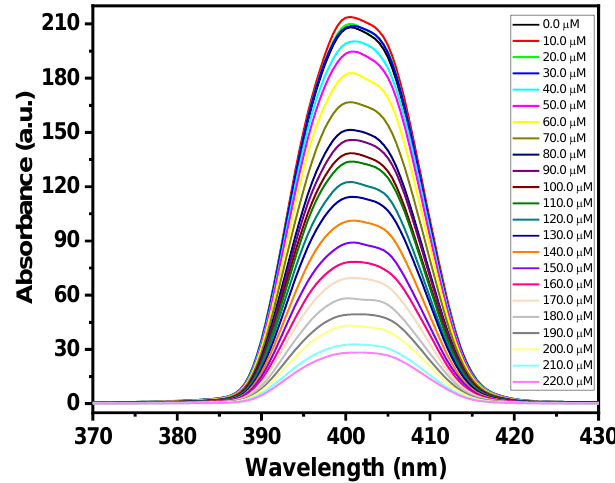
Figure 6. Fluorescence quenching of the CdO-ZnO nanocomposites by hydrazine.